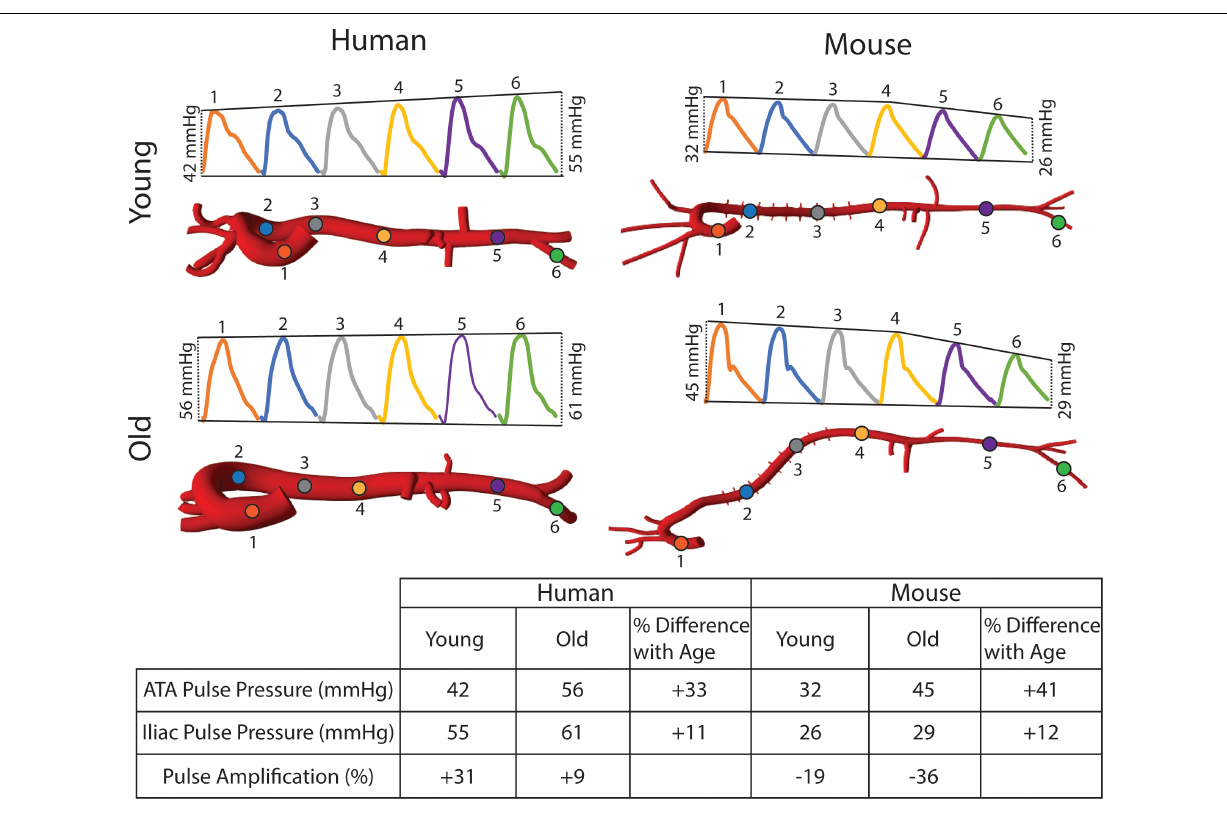
FIGURE 9 | Pulse pressure amplification manifests in the human aorta, but not the